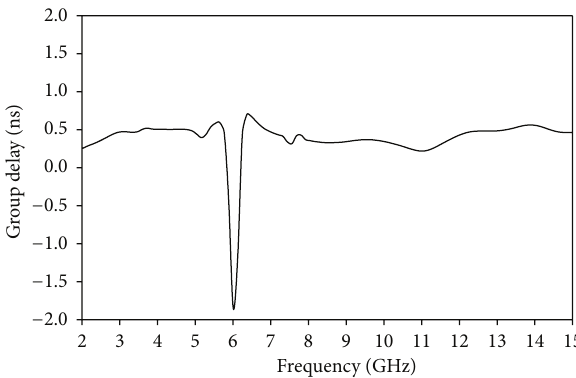
Figure 11: Group delay of the proposed notched antenna.